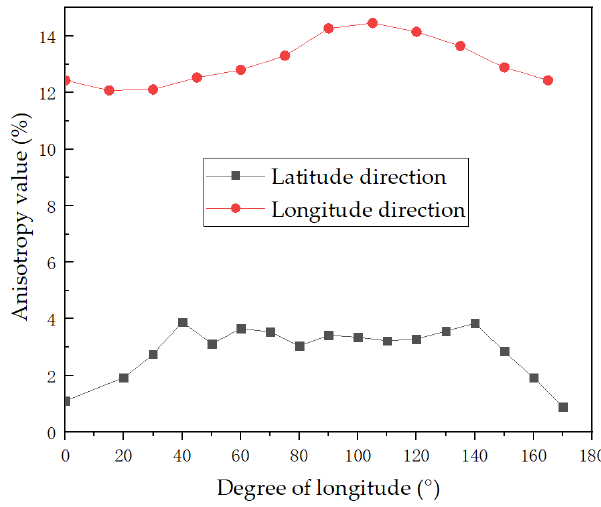
Figure 8. Velocity anisotropies in the longitudinal direction and latitudinal direction. The velocities of the longitudinal and shear waves of the same testing point were combined and fitted. Their relationships are shown in Figure 9. Their velocities were pos- itively related. Their relationship equation is shown in Equation (2).